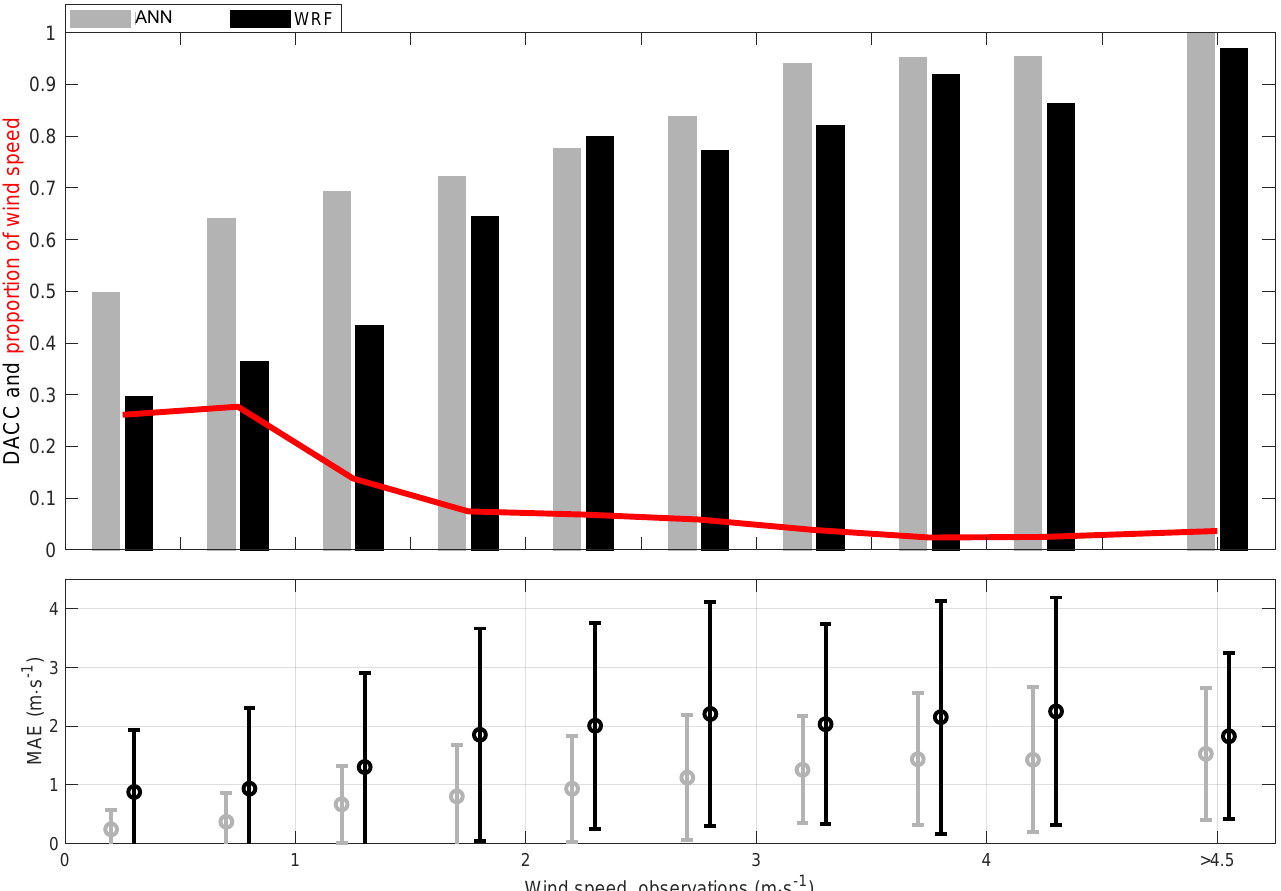
Figure 11. ( Top panel ) Comparison of DACC values between WRF and the ANN for bins (of 0.5ms − 1 ) of observed 2 m wind speed. The red line indicates the proportion of data in each bin. ( Bottom panel ) Comparison of mean absolute error (MAE) and standard deviation of forecast error for the speed forecast. WRF results are in black and ANN results are in